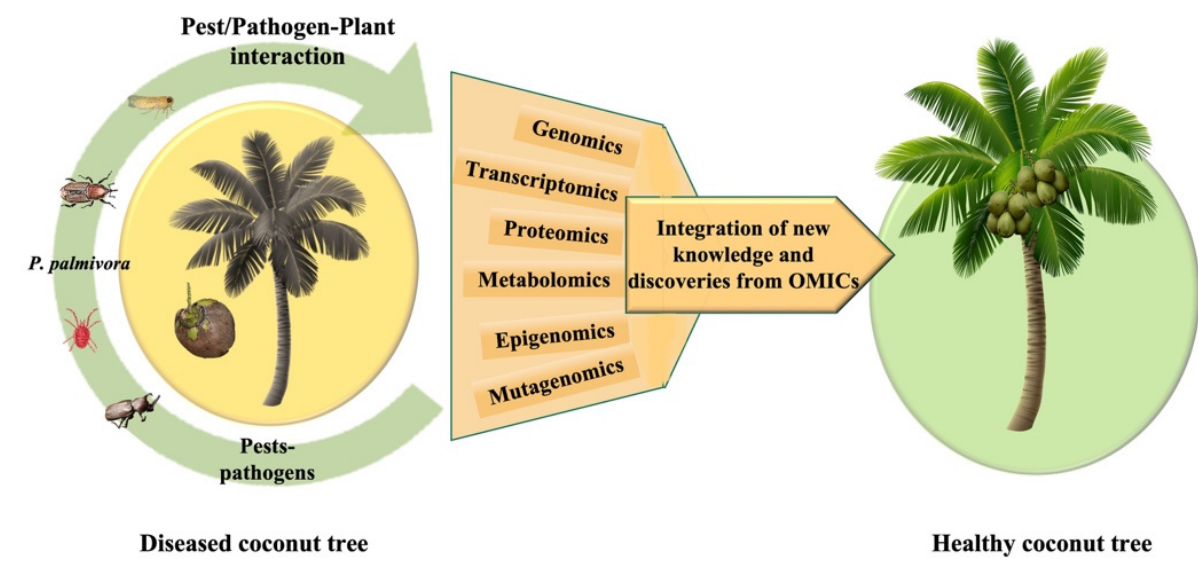
Figure 3. Schematic figure representing the contribution of the omics studies to our current understanding of the coconut and pathogen/insect interaction, as well as their contribution to the identification of novel strategies for pest and disease control.